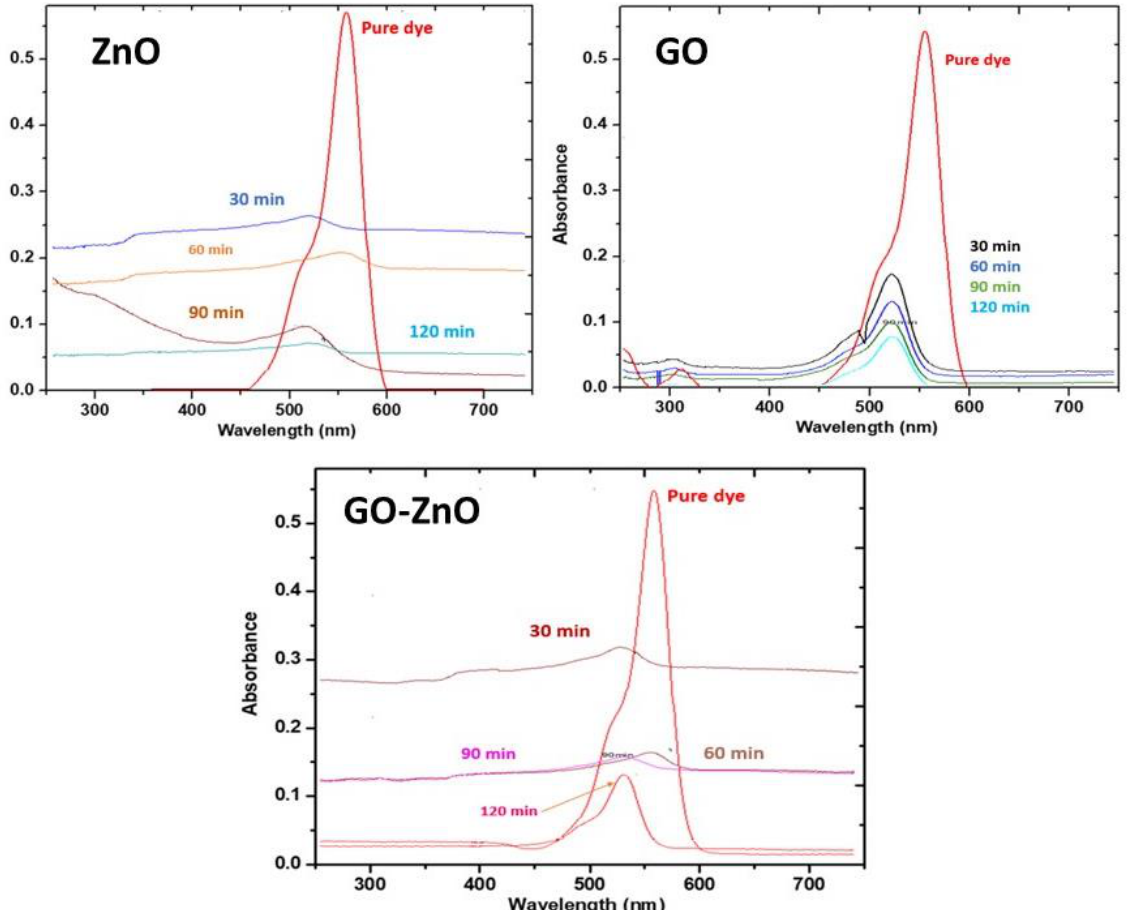
Figure 8. UV-vis spectrum of rhodamine 6G at λ max = 555 nm, and photodegradation of rhodamine 6G using ZnO, GO and GO-ZnO at different time intervals.